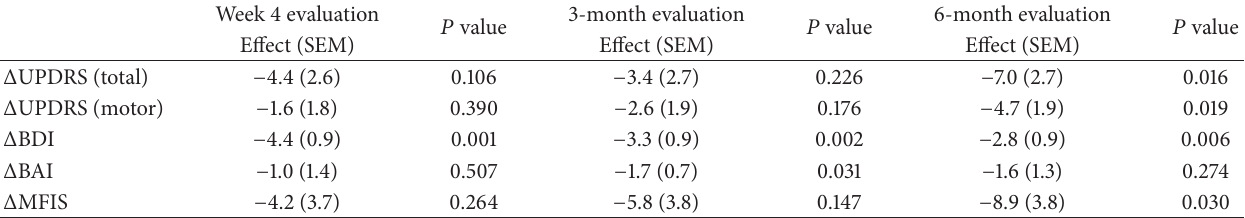
Table 2: Clinical changes from baseline after exercise interventions in both groups ( 𝑁 = 11 ).